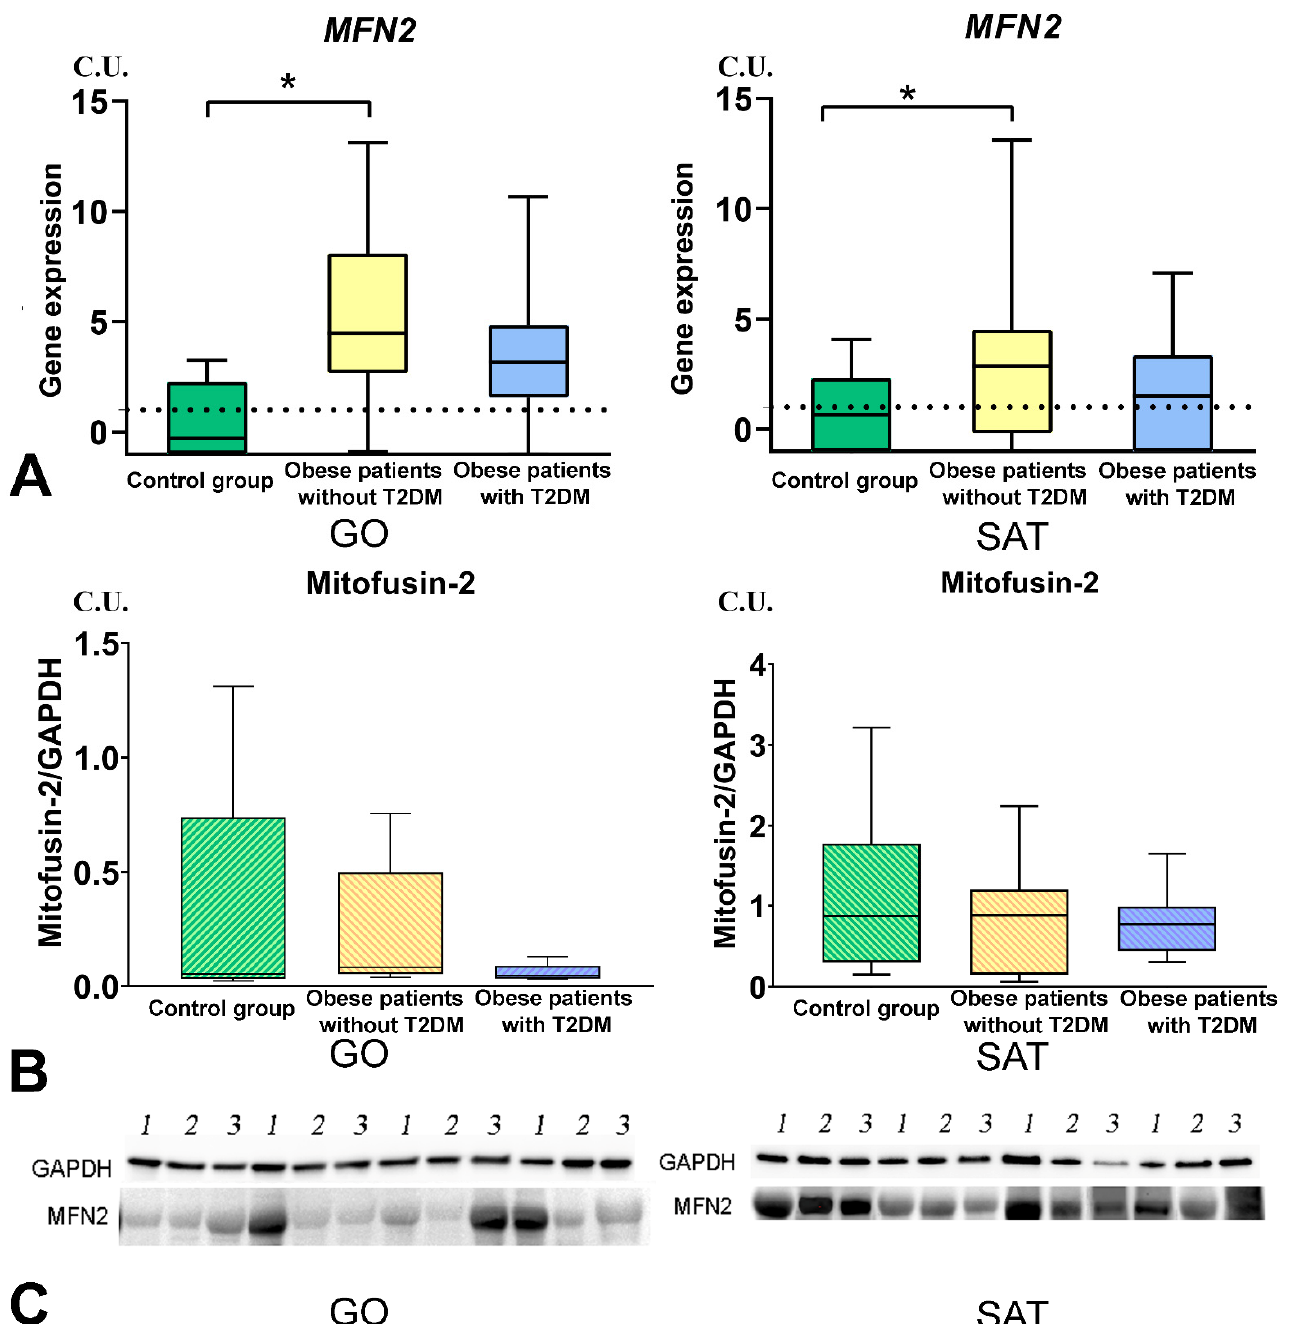
Figure 7. Study of tissue-specific production of MFN2 in obese patients with and without T2DM. ( A )—MFN2 genes expression in GO and SAT, n = 25; ( B )—Mitofusin-2 protein production in GO and SAT, Western blot analysis of AT biopsies, n = 8; ( C )—Protein MFN2 Western blot bands, n = 8. *— p < 0.05 significance is determined using the Mann–Whitney criterion for two independent samples.